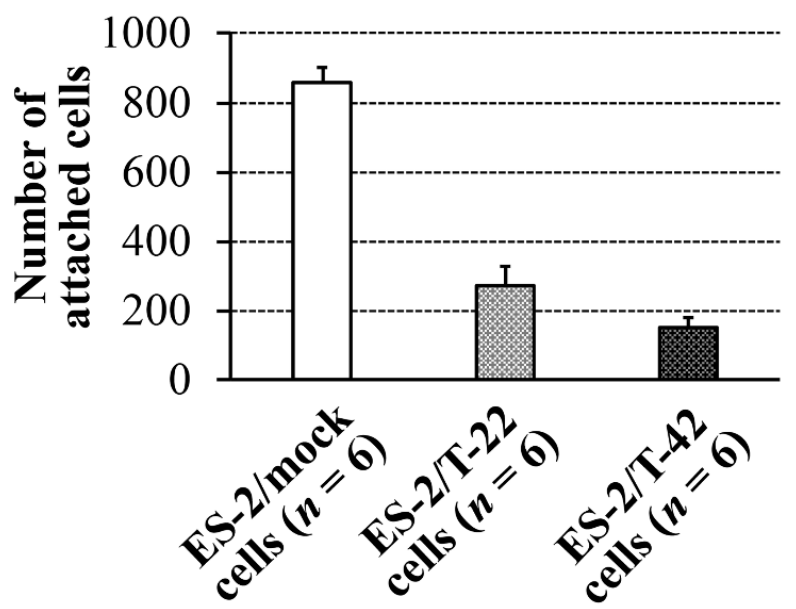
Figure 1. Adhesion of ES-2/mock cells, ES-2/T-22 cells, and ES-2/T-42 cells to peritoneal mesothelial cells. The Y -axis indicates the number of cells attached to the mesothelial cell monolayer 30 min after seeding. Data shown are mean ± SEM. Kruskal-Wallis rank sum test. p < 0.05. To verify these in vitro findings by in vivo experiments, suspensions of ES-2/mock cells, ES-2/T-22 cells, and ES-2/T-42 cells in 1 mL HBSS were injected into the peritoneal cavity of nude mice. Three weeks after inoculation, mice were sacrificed, and the presence of peritoneal metastasis was examined. Mice that received ES-2/mock cells appeared to experience increased levels of peritoneal dissemination compared to mice that had received ES-2/T-22 cells or ES-2/T-42 cells. Mice that received ES-2/mock cells had small-sized tumors throughout the peritoneal cavity (Figure 2A), whereas mice that received ES-2/T-42 cells had bloody ascites but showed no visible metastatic implantation onto the peritoneal cavity (Table 1, Figure 2B). A significantly smaller tumor burden was found in mice that received ES-2/T-42 cells compared to ES-2/mock cells when the weight of tumor bearing tissues was compared (Figure 2C). These results appeared different from the results shown in our previous report, where cancer cells were subcutaneously injected [15]. The survival rates of mice intraperitoneally inoculated with ES-2/mock, ES-2/T-22 cells, and ES-2/T-42 cells after 3 weeks were 42.9%, 90.9%, and 100%, respectively (Table 1). Intraperitoneal injection of ES-2/T-42 cells expressing MUC1 and high levels of mAb MY.1E12 binding resulted in the production of a large amount of ascites (Table 1). Ascitic growth of ES-2/T-42 cells seemed to be due to increased growth under anoikis conditions, as we previously reported